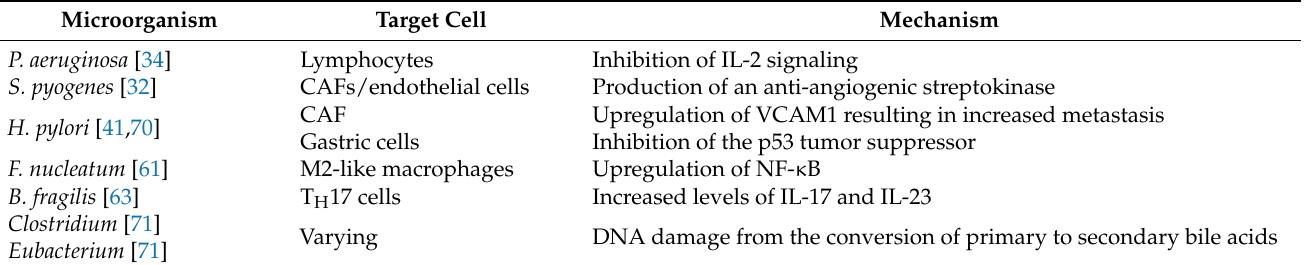
Table 1. A summary of the role of microbiota on the development and progression of